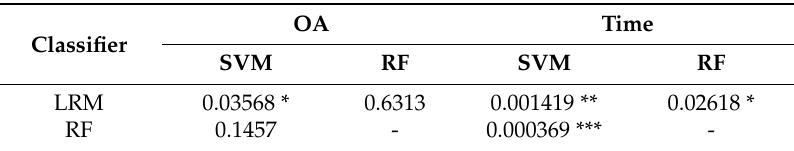
Table 4. Summary of the paired t -test for LRM, SVM and RF for both OA and computing time. Statistical significance is given as follows: *** p < 0.001; ** p < 0.01; * p <